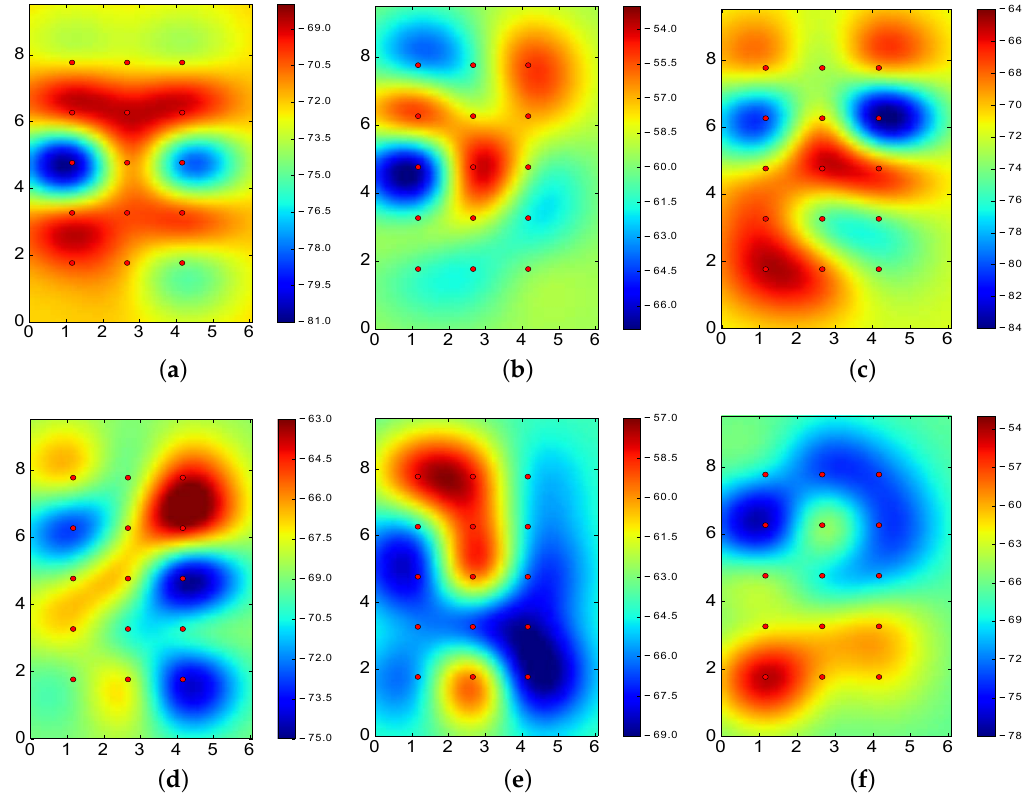
Figure 11. RSSI values for different transmission power levels ( Tx ) for BLE4.0 beacons ’Be11’, ’Be07’ and ’Be08’. ( a ) ’Be11’ with Tx = 0x03; ( b ) ’Be07’ with Tx = 0x01; ( c ) ’Be08’ with Tx = 0x05; ( d ) ’Be11’ with Tx = 0x04; ( e ) ’Be07’ with Tx = 0x04; ( f ) ’Be08’ with Tx =